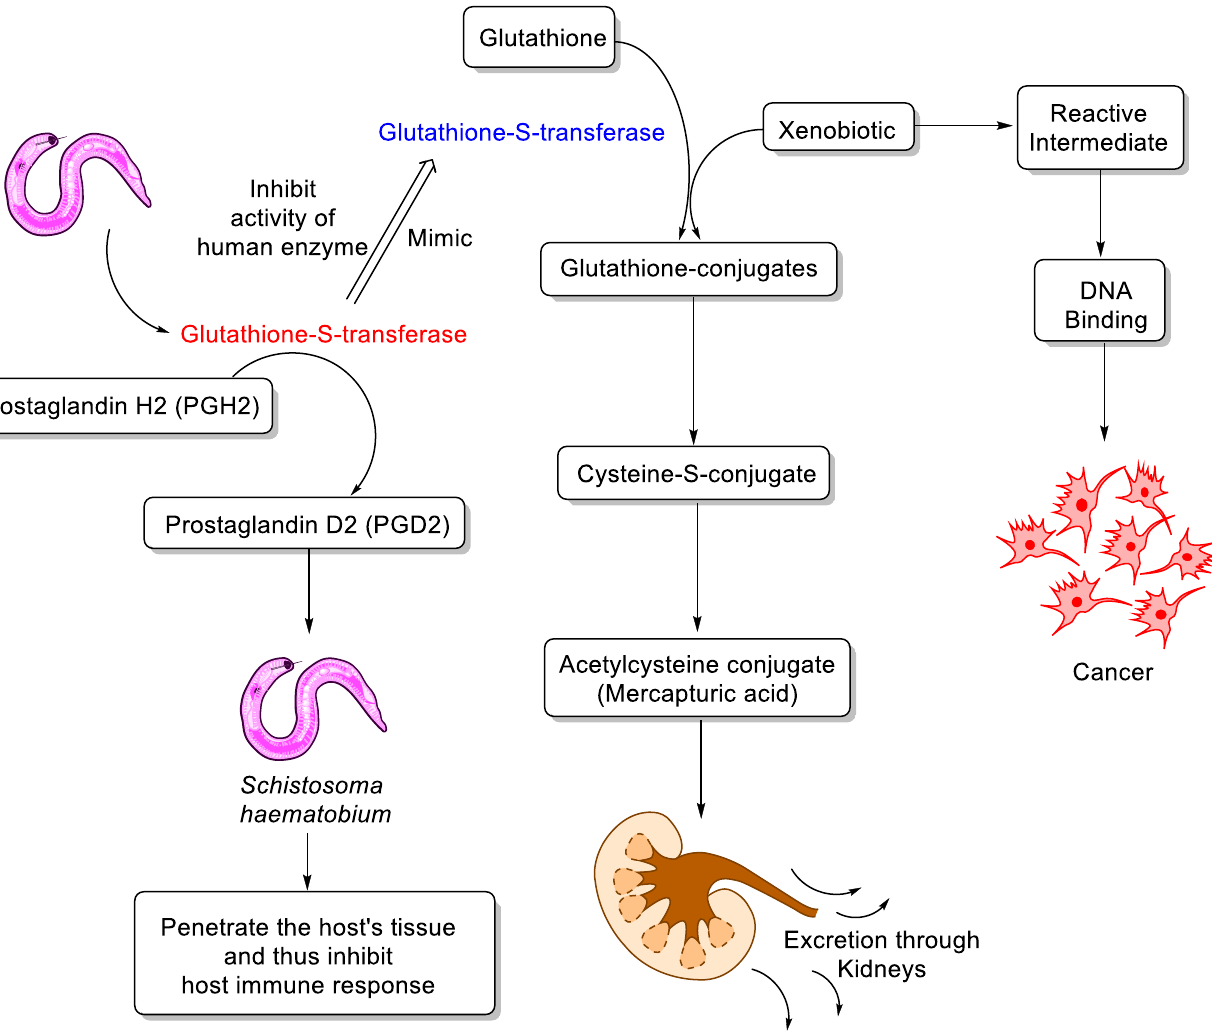
Figure 1. Schematic view and biological role of glutathione S-transferases (GSTs) in Schistosoma parasite and cancer. The molecular pathways underlying the evolution of different cancers have been extensively elucidated, and investigations are now focused on exploring the receptor pro- teins and their targeted chemical agents for treatment of this disease [17,18]. Amongst them, vascular endothelial growth factor (VEGF), an important angiogenesis activating protein, facilitates the proliferation of endothelial cells to form the new blood vessels during angiogenesis induced by pathological conditions such as solid tumor growth and, in turn, nourishes them by delivering oxygen and nutrients [19]. A large number of proangio- genic factors including VEGF, basic fibroblast growth factor, hepatocyte growth factor and angiogenin are often overexpressed in tumors. Several studies have indicated that